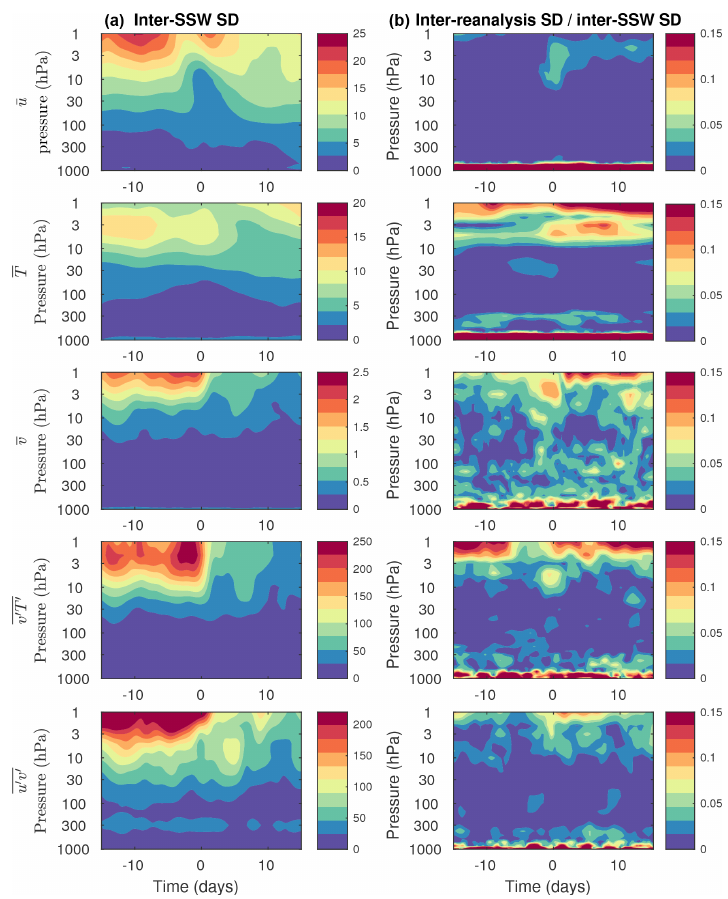
Figure 4. Similar to Fig. 3 except showing (a) the standard deviation (SD) among SSW events and (b) the standard deviation among reanalysis datasets divided by the standard deviation among SSW